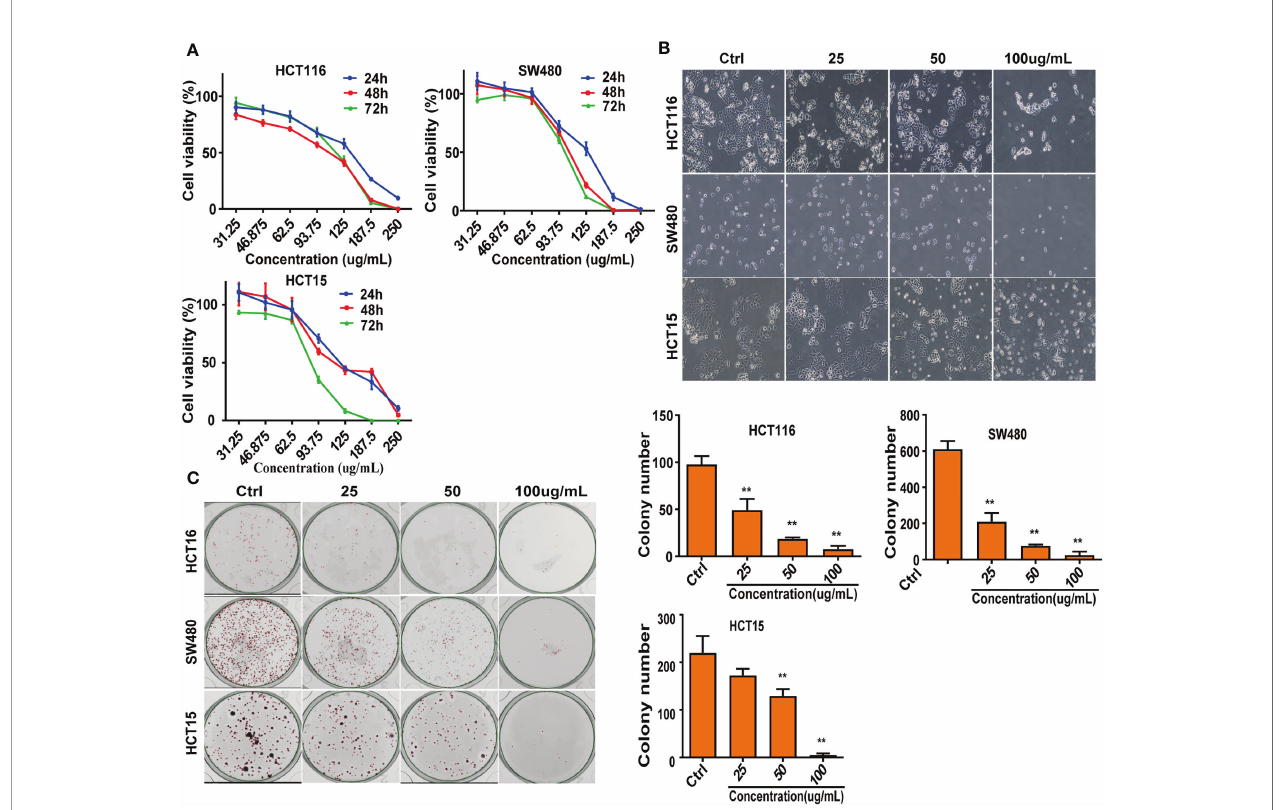
FIGURE 1 | Suppress of cell lines growth in vitro . (A) After intervention with CNC extract, cell viability was measured by MTS assay. (B) Cell morphology were observed after treatment with CNC extract. (C) Number of cell clones after treatment with CNC extract. There were three duplicate samples in each experiment. Data are expressed as mean ± SD. Compared with control group: **p <